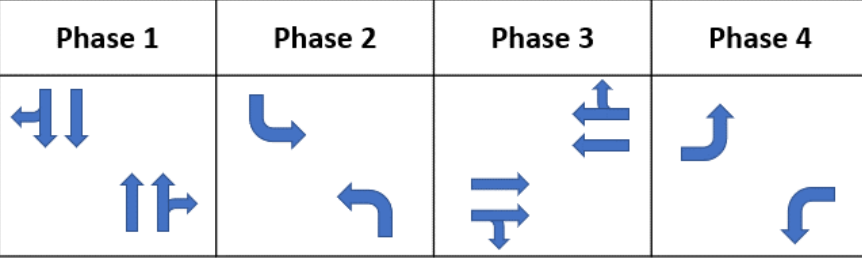
Figure 5. Operational settings for traffic signals.